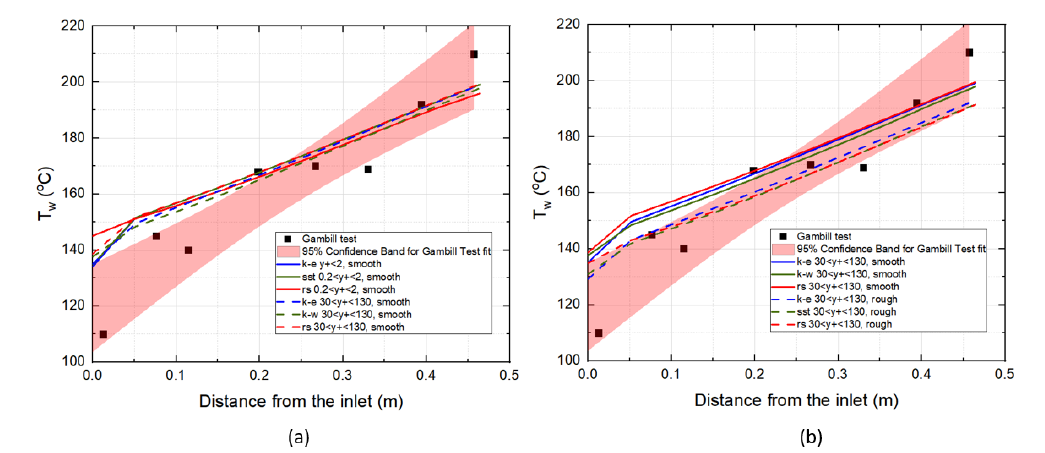
Figure 4: The wall temperature profiles for all Ansys CFX simulations are shown. In part (a), a comparison is made between mesh 1 and 2, while in (b) the smooth and rough walls in the case of mesh 1 are compared.